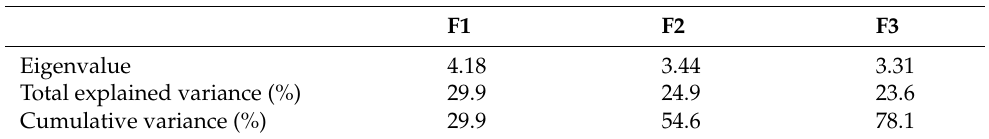
Table 5. Eigenvalues, proportion of the total variance covered by each factor and the cumulative explanation of data variance.